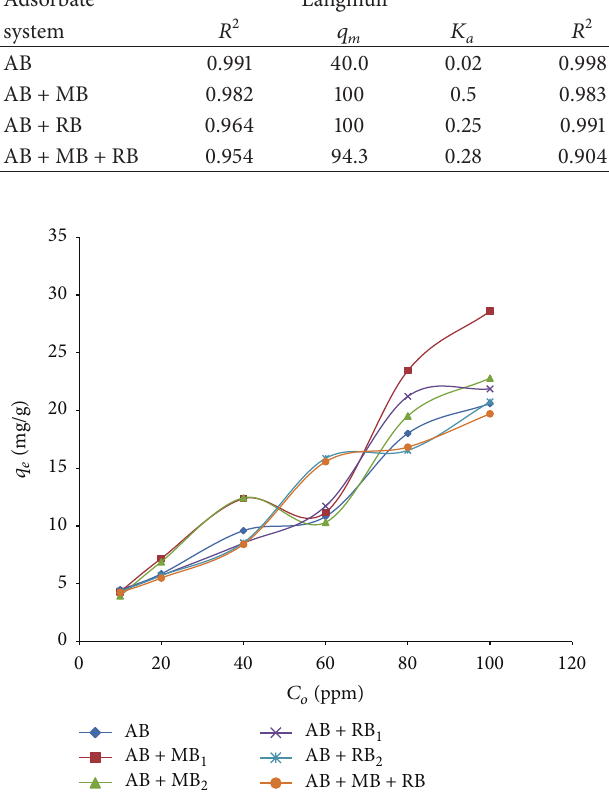
Figure 6: Effects of initial dye concentration on adsorption of Acid Blue 161 on RSD.